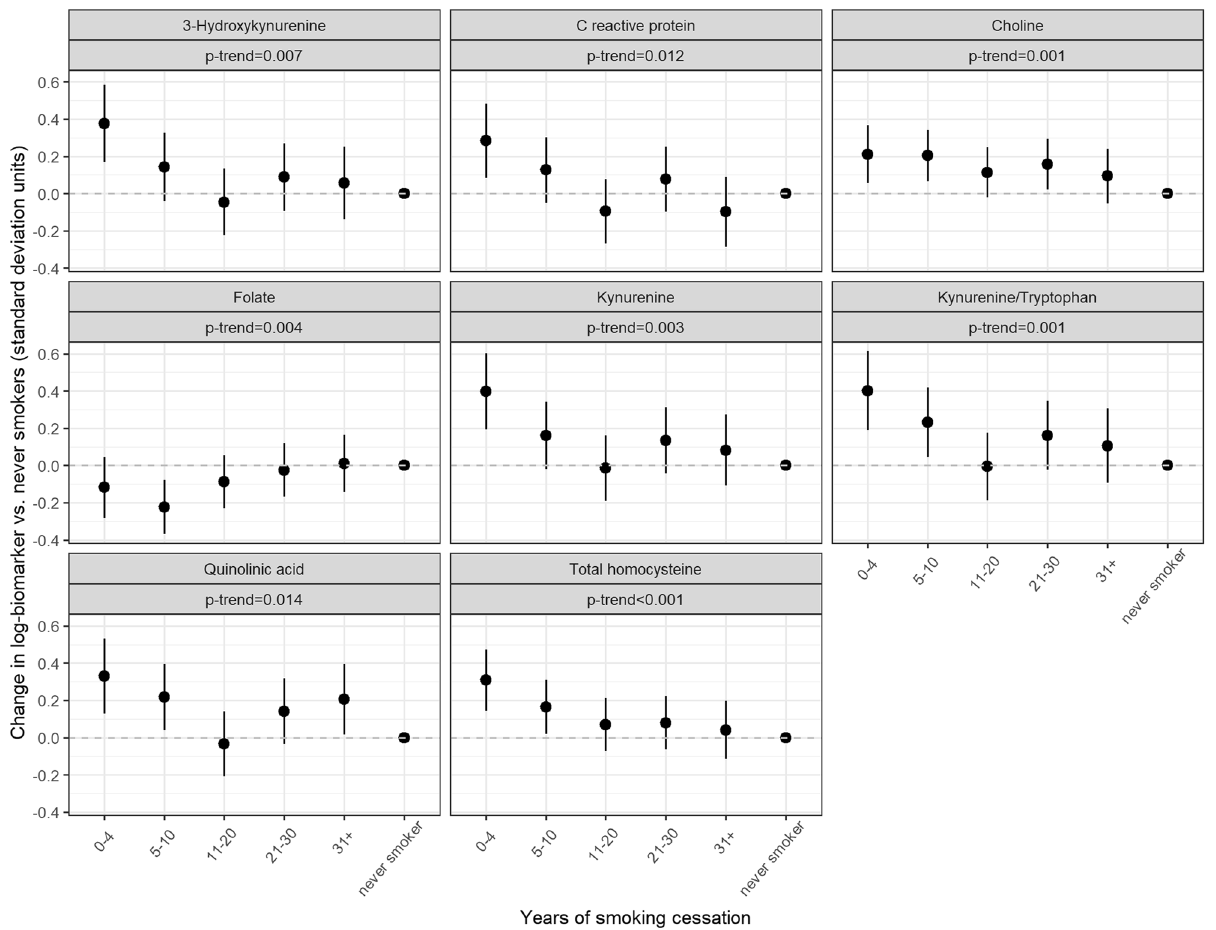
Figure 5. Trends in biomarker measurements among former smokers, by years of smoking cessation, for biomarkers with statistically significant trends ( p < 0.05), among 1427 control subjects in selected cohorts from the Lung Cancer Cohort